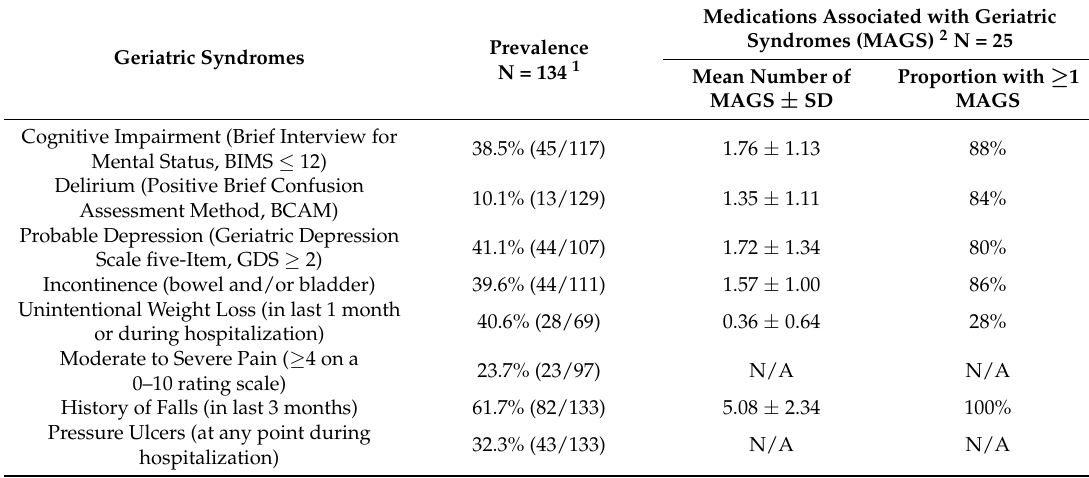
Table 2. Prevalence of geriatric syndromes and medications associated with geriatric syndromes in Veterans Affairs (VA) patients discharged to skilled nursing